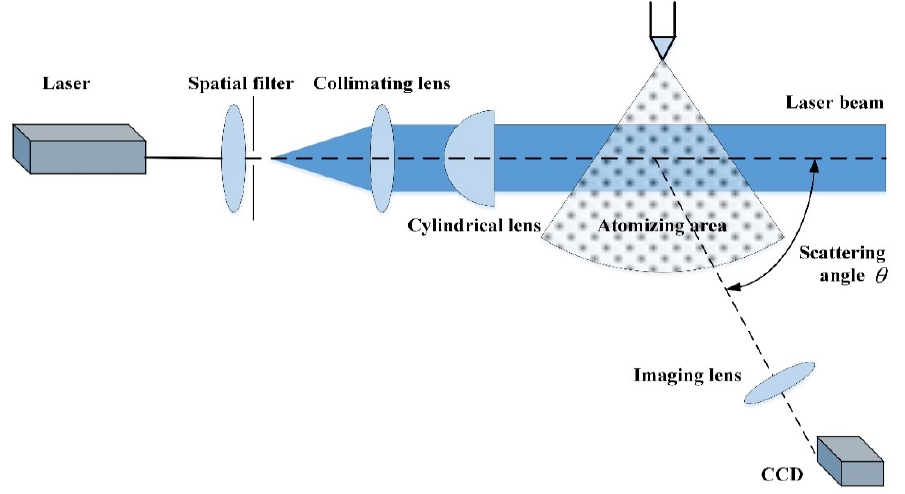
Figure 4. Schematic diagram of the IPI measurement optical system for colliding particle field.